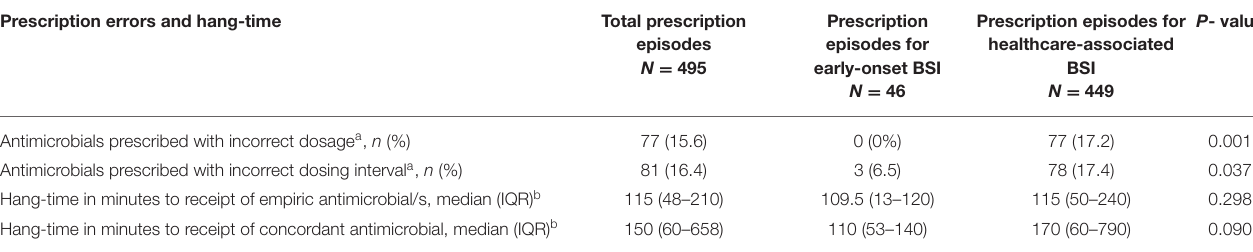
TABLE 3 | Antimicrobial prescription errors and hang-time.